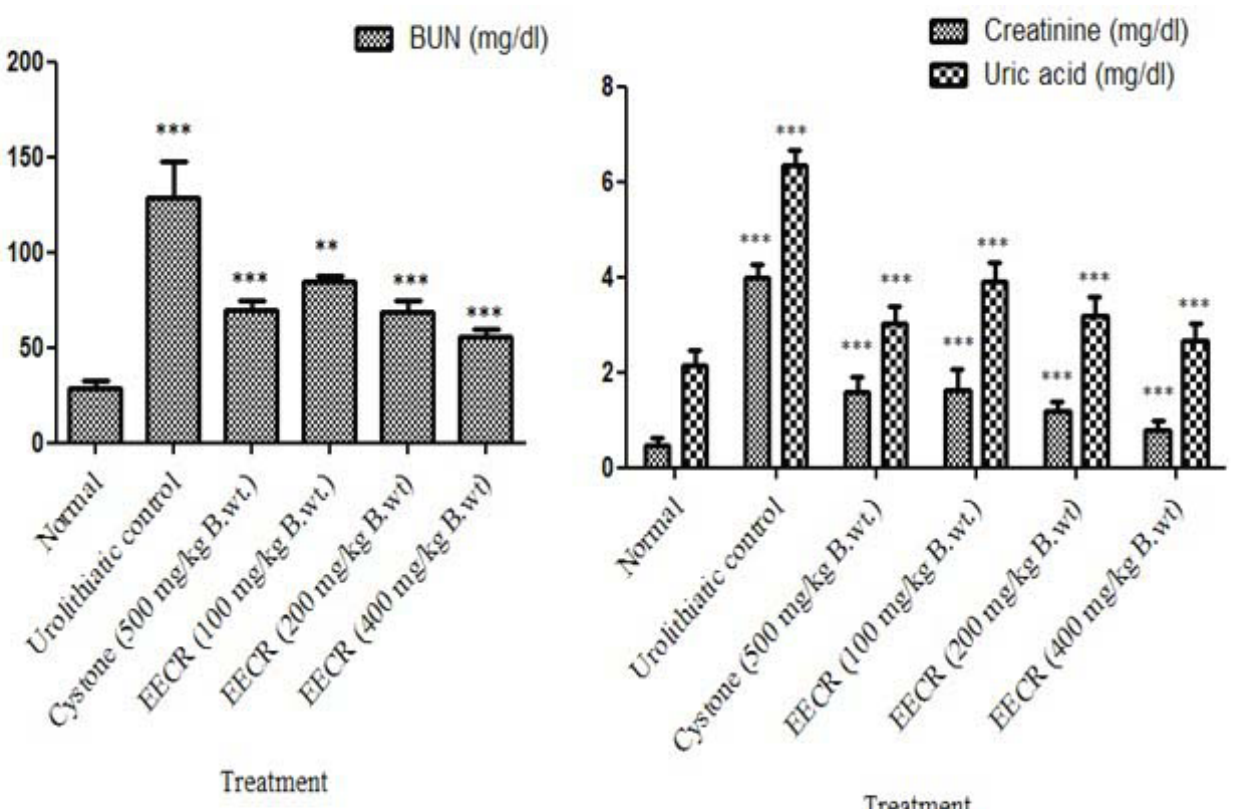
FIGURE 4 - Effect of EECR on serum BUN, creatinine, uric acid in urolithiasis rats.